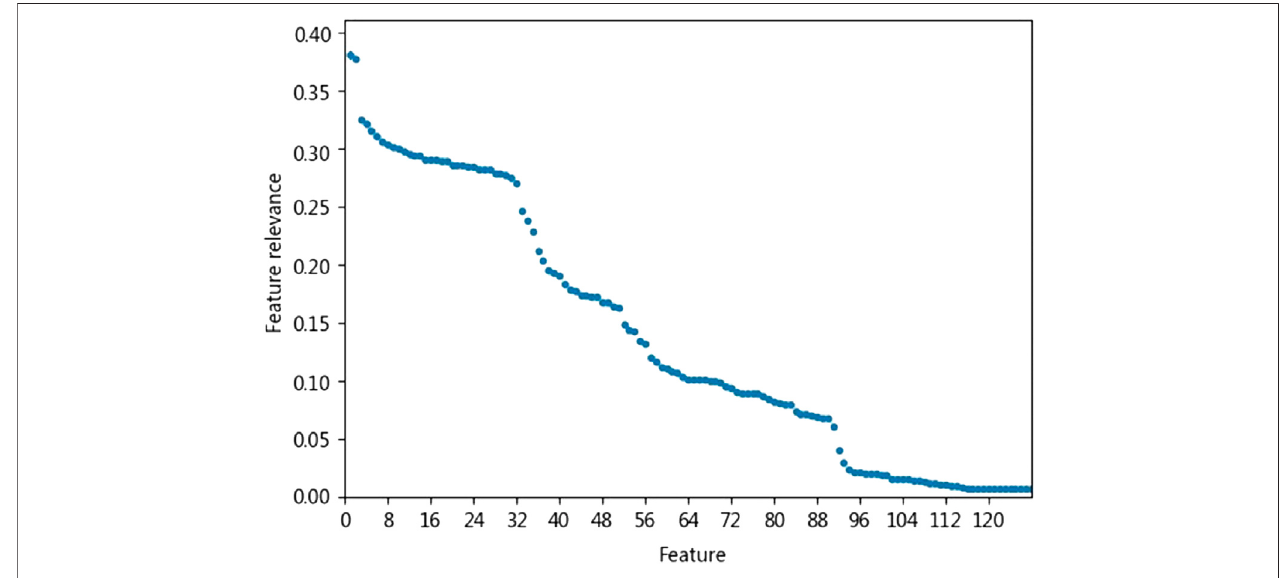
FIGURE 4 | Attack gene feature correlation ranking.